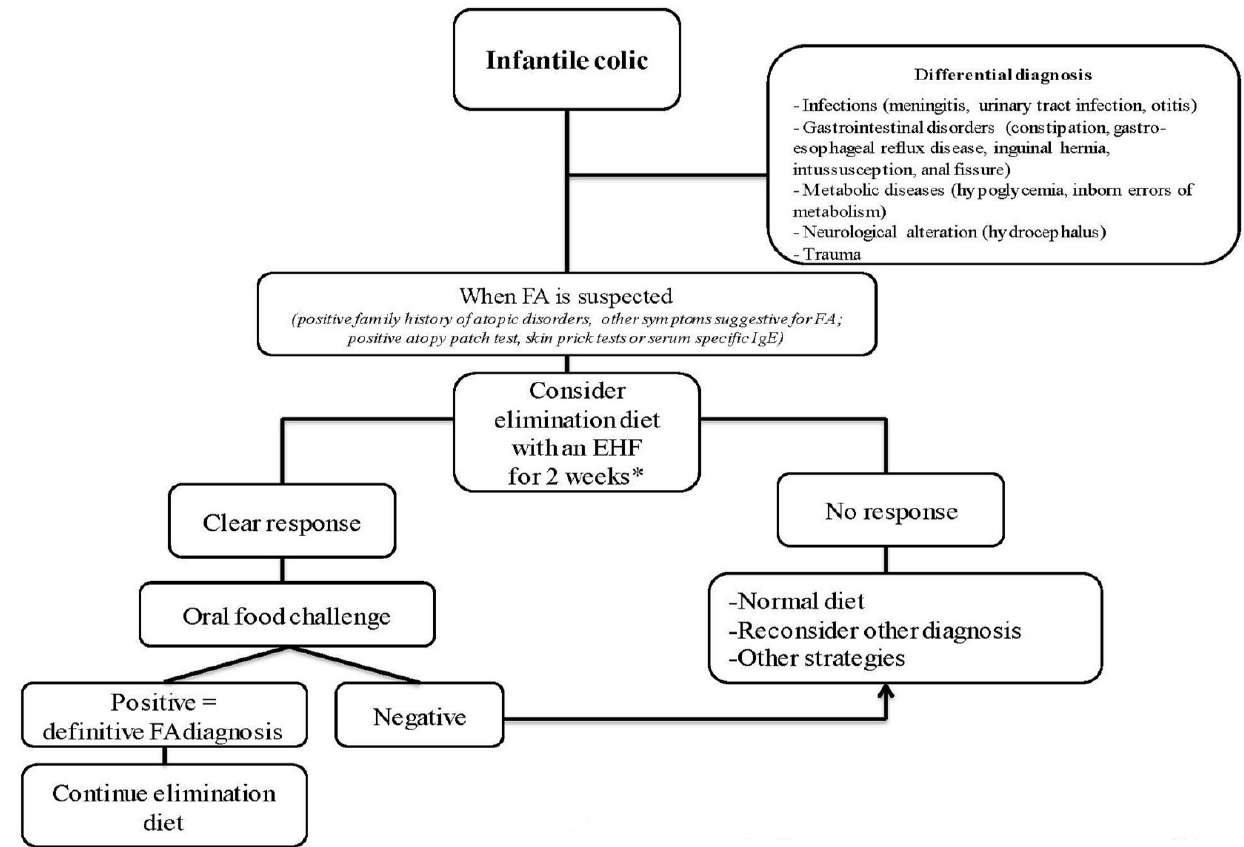
Figure 2. The diagnostic approach for suspected food allergy-induced infantile colic in formula-fed babies. *, If the child is breastfed it could be consider a monitored hypoallergenic maternal diet avoiding eggs, peanuts, tree nuts, wheat, soy, fish, cow’s milk protein containing foods; EHF: extensively hydrolyzed formula; FA: food allergy; IgE: immunoglobulin